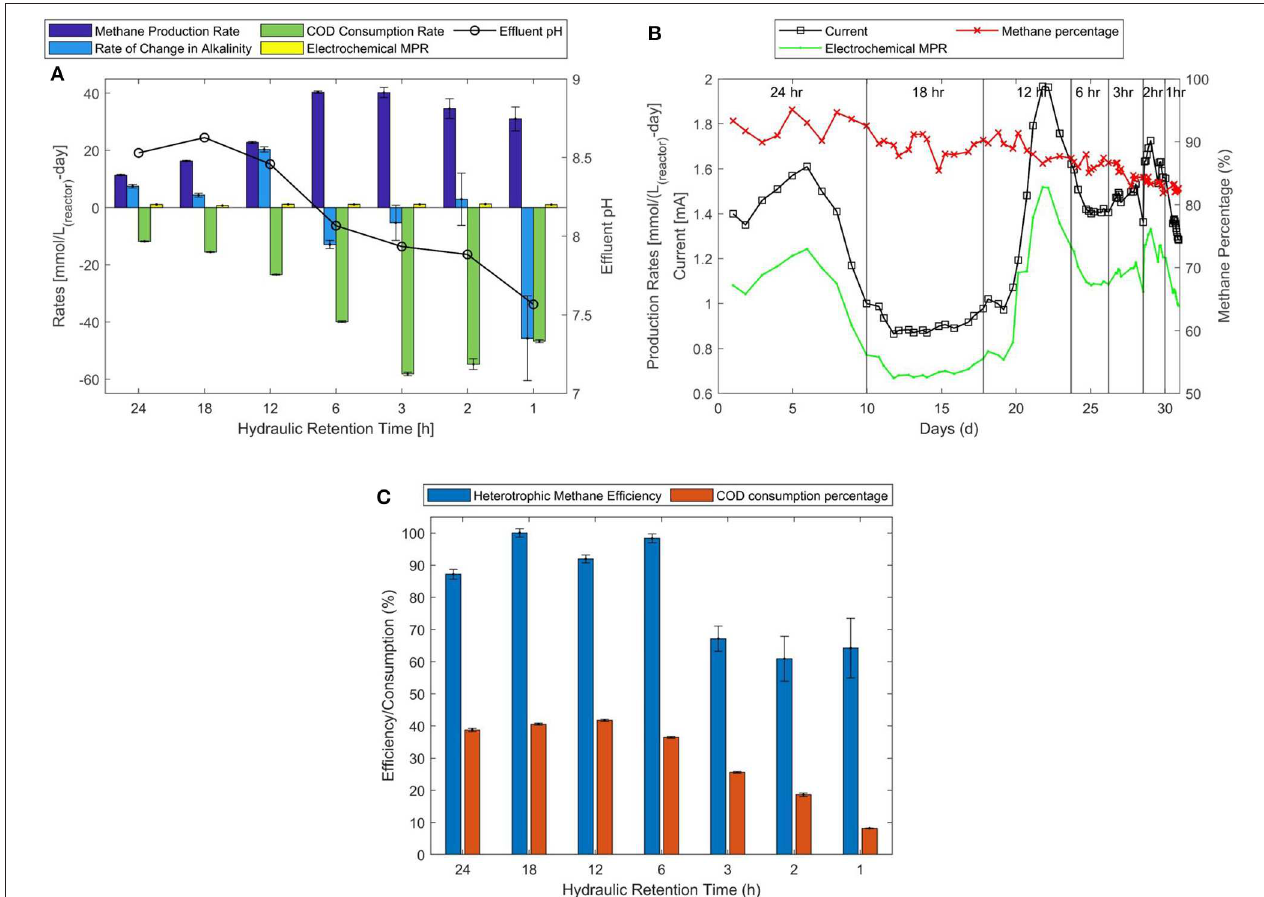
FIGURE 2 | HRT experiments conducted with feed containing supplemented acetic acid. (A) Overall and electrochemical methane production rates, methane percentage in the biogas, and current measured. (B) Average overall and electrochemical methane production rates, rates of changes in COD and alkalinity. (C) Amount COD consumed and the heterotrophic efficiency to produce